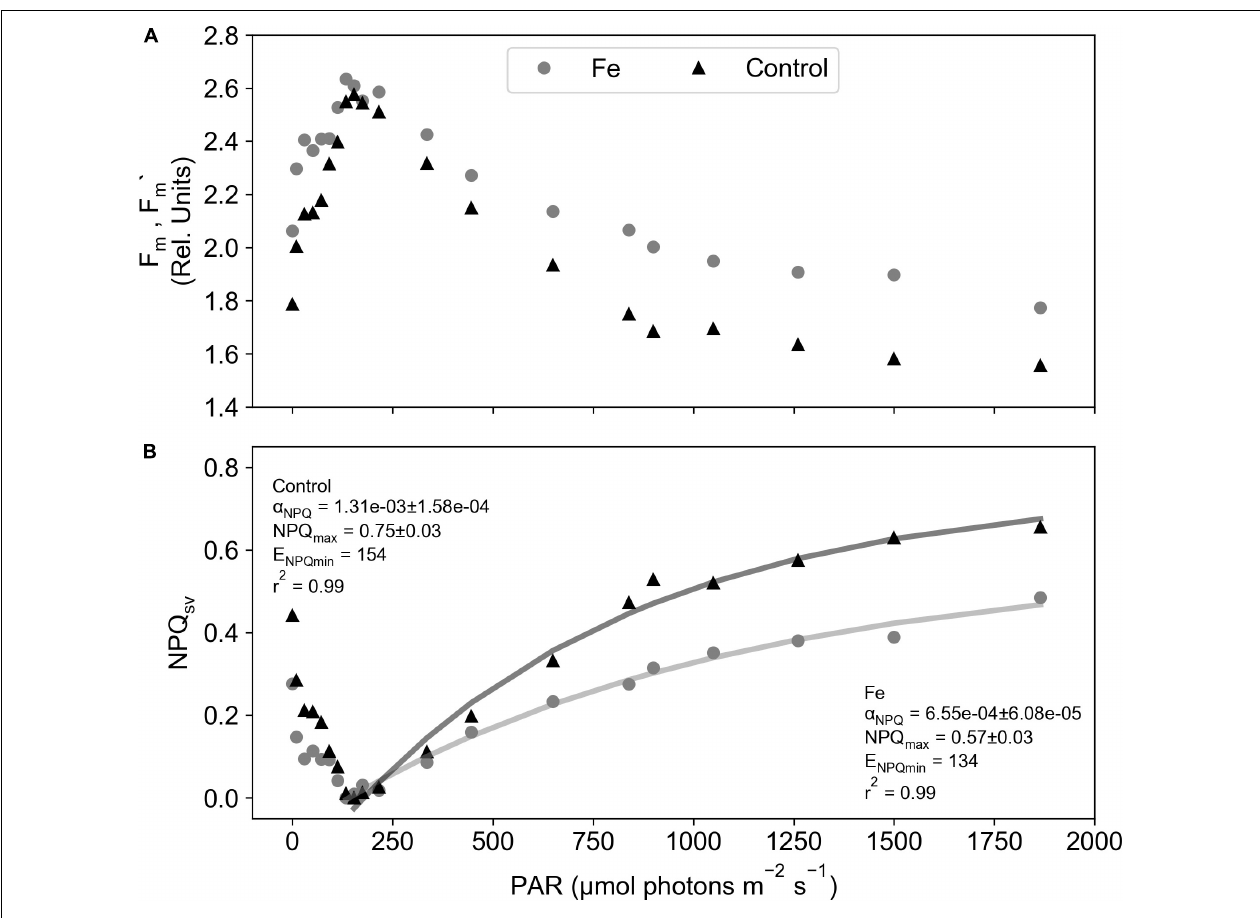
FIGURE 1 | Example chlorophyll fluorescence data from the iron and control treatments of nutrient addition incubation experiment 2 measured at 120 h from Ryan-Keogh et al. (2018a,b); (A) Maximum fluorescence in the dark (F m ) and under actinic light (F m ’), (B) non-photochemical quenching (NPQ sv ) and (C) NPQ sv corrected for E NPQmin fitted with the Platt et al. (1980)